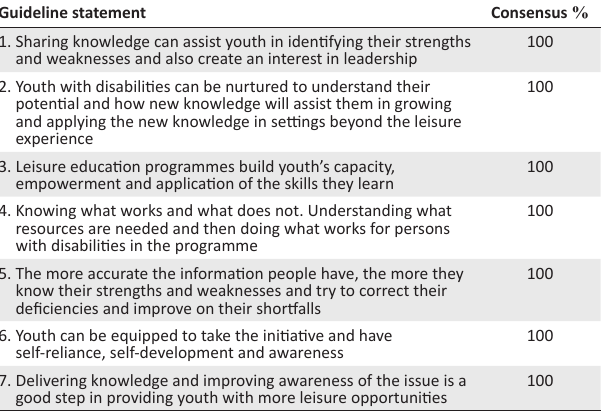
TABLE 9: The benefits of knowledge sharing for leadership development among youth with physical disabilities. Guideline statement